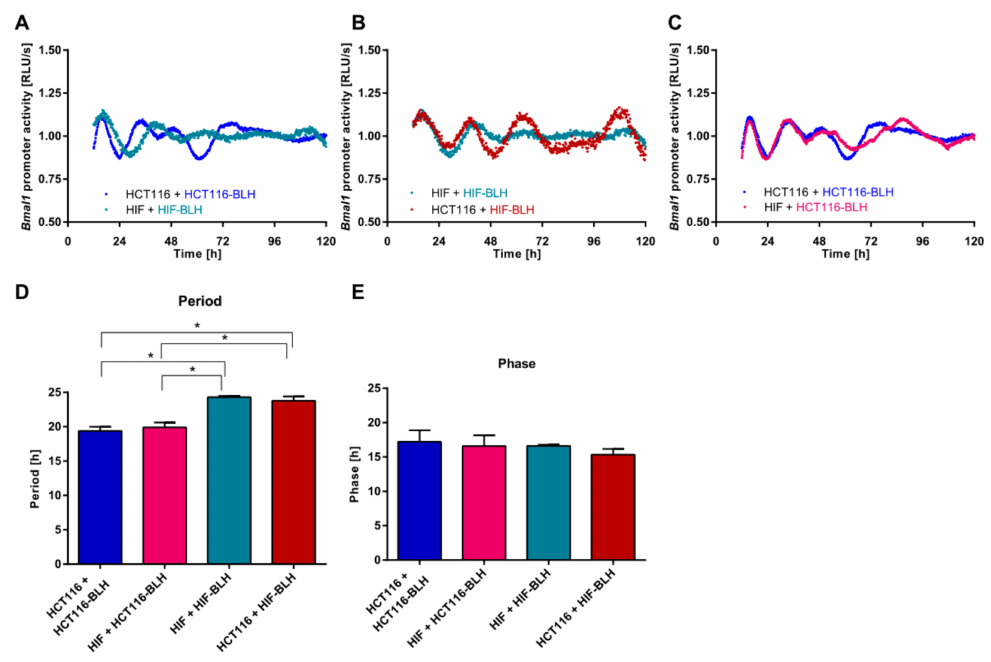
Figure 1. E ff ect of co-culture on circadian rhythms in HCT116 and human intestinal fibroblast (HIF) cells. Cells were lentivirally transduced and the human BMAL1 -promoter (BLH) activity was measured over five consecutive days. Cells were either co-cultured with the same cell line ( A ) or with a di ff erent cell line ( B , C ). Shown is one representative replicate per condition. The BLH-cell line was measured. Period ( D ) and phase ( E ) were calculated in samples with and without co-culture. Data are expressed as mean ± SEM, n = 3. Significant changes ( p < 0.05) between di ff erent conditions are marked with